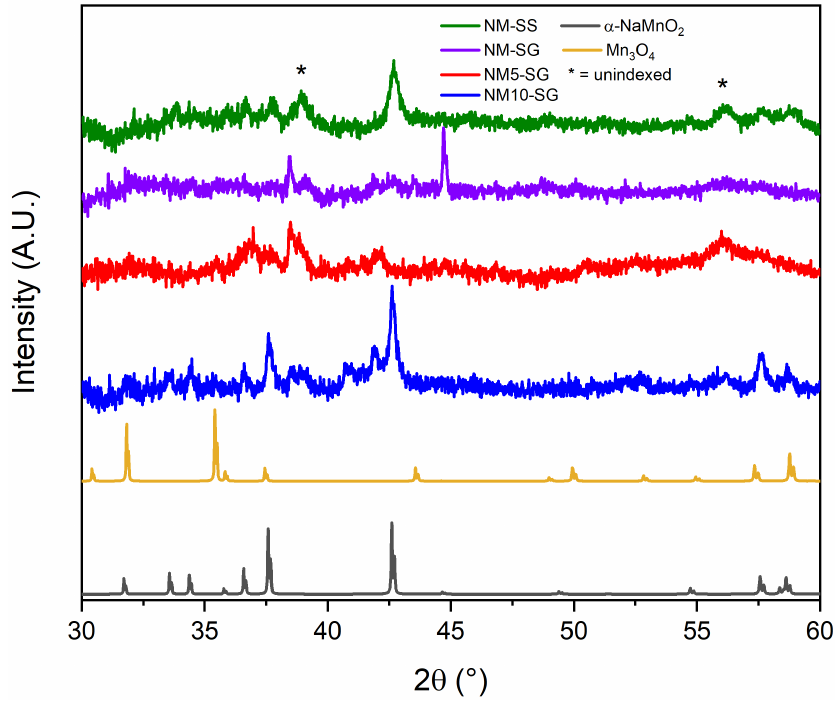
Figure 8. Experimental XRD patterns of post-mortem electrodes made from the four materials compared to theoretical ones ( α -NaMnO 2 [30] and Mn 3 O 4 [44]) calculated by VESTA